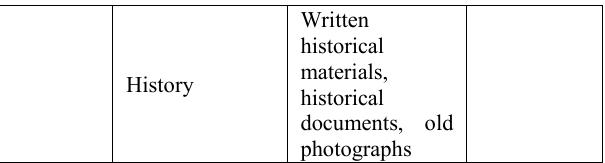
Table4. Table of basic requirements for restoration results